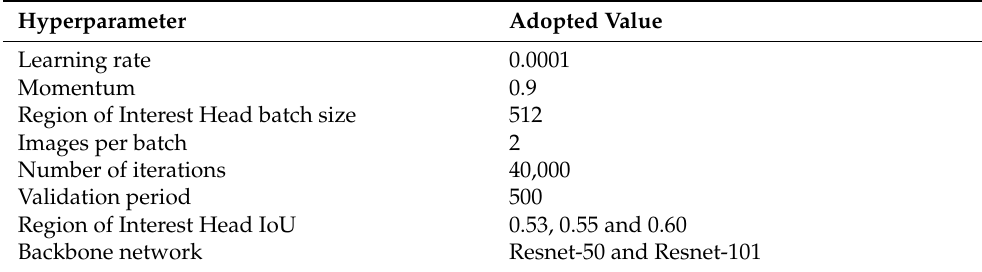
Table 2. Hyperparameters and adopted values for training of Mask